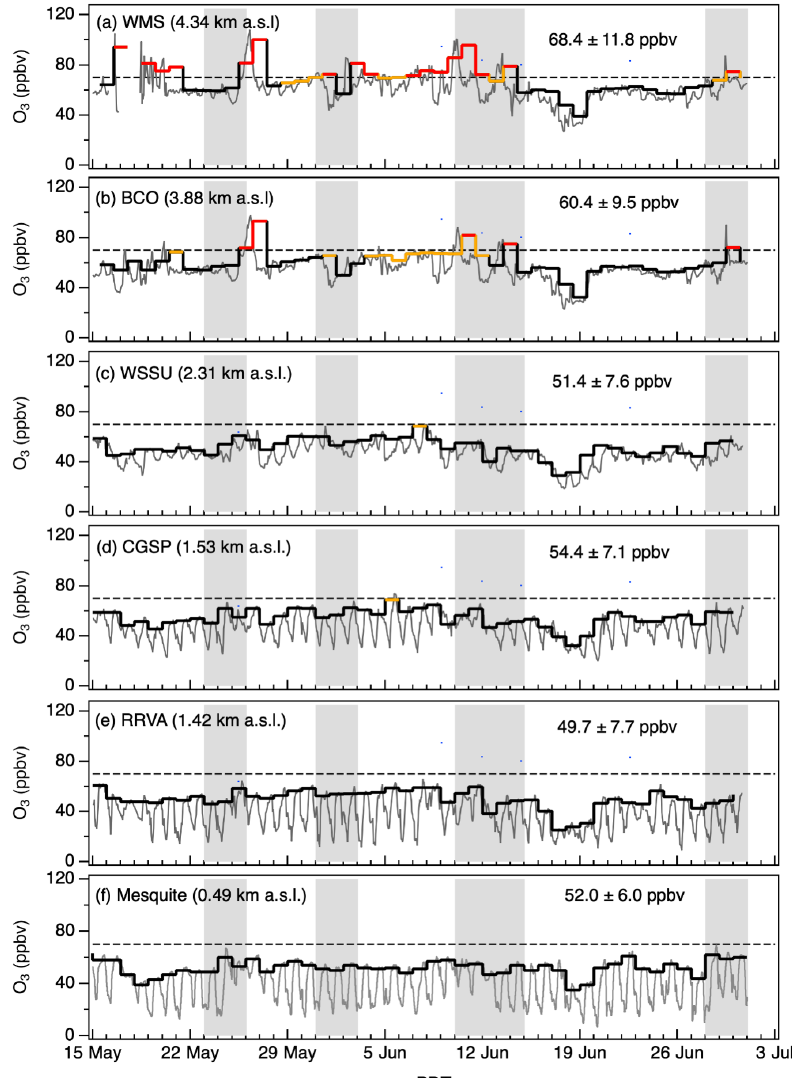
Figure 19. Time series of the 1h average (gray line) and MDA8 O 3 (black staircase) measurements from the remote monitoring sites. The monitor elevations are shown in parentheses. (a) White Mountain Summit, (b) Barcroft Observatory, (c) Warm Springs Summit, (d) Cathedral Gorge State Park, (e) Railroad Valley, and (f) Mesquite. MDA8 O 3 concentrations exceeding the 2015 NAAQS of 70ppbv (dashed line) and a potential NAAQS of 65ppbv are highlighted in red and orange, respectively. The gray bands show the four IOPs. The mean concentrations ( ± 1 σ ) are calculated from the 15 May to 30 June MDA8 O 3